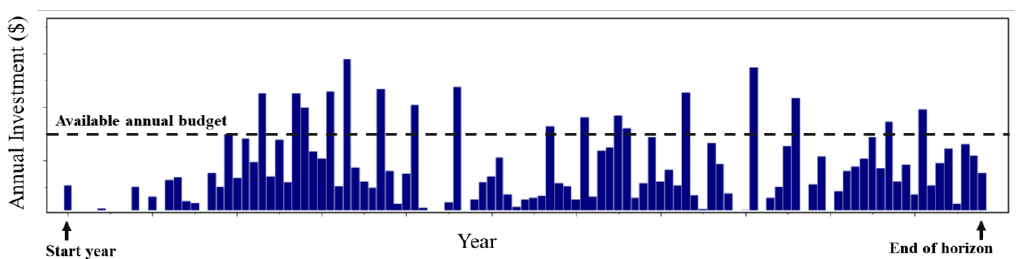
Figure 3. Annual investment time series without smoothing (the dashed line indicates an annual budget limit).